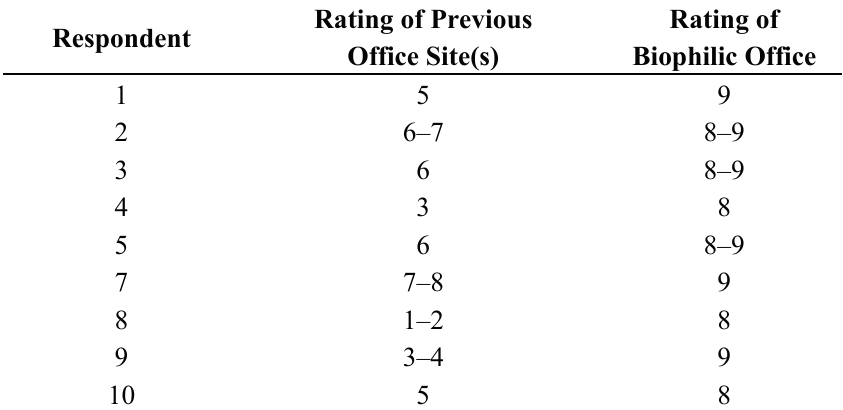
Table 4. Rate this office against previous offices you have worked in (score out of 10, 1 = very poor, 10 =